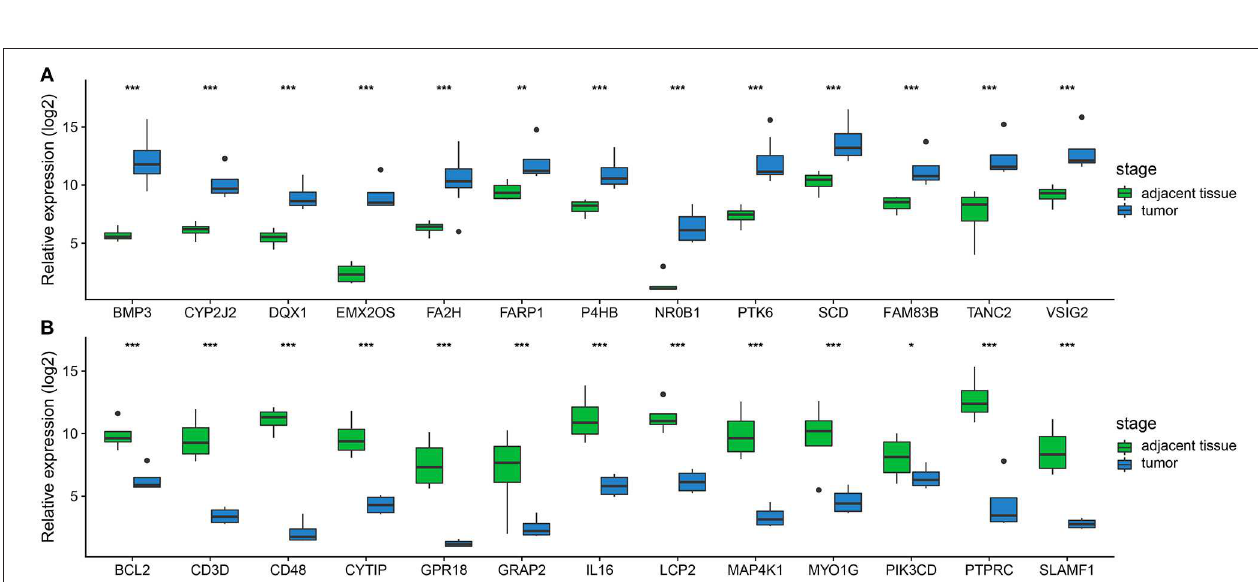
FIGURE 4 | Validation of DEGs by qRT-PCR. (A,B) Boxplots indicate the medians and dispersions of 24 bladder cancer and their adjacent tissue samples. P -values are counted by student’s t -test, * p < 0.05, ** p < 0.01, *** p < 0.001.